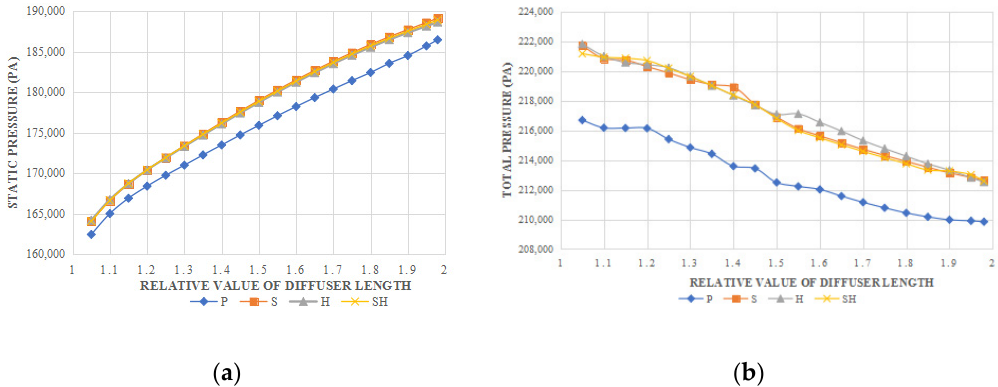
Figure 12. Mean static pressure and total pressure distribution along the diffuser length direction at 1 relative mass flow: ( a ) static pressure distribution; ( b ) total pressure distribution.